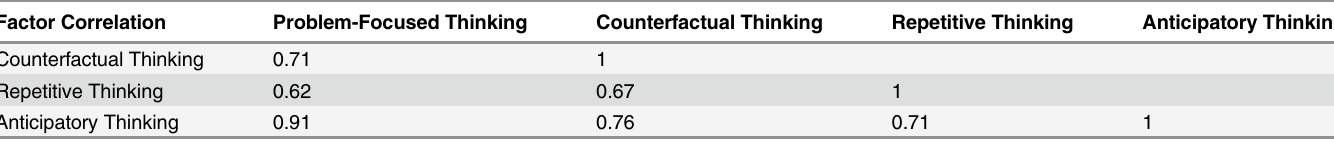
Table 5. Factor Correlations for the Four-Factor Rumination Model. Factor